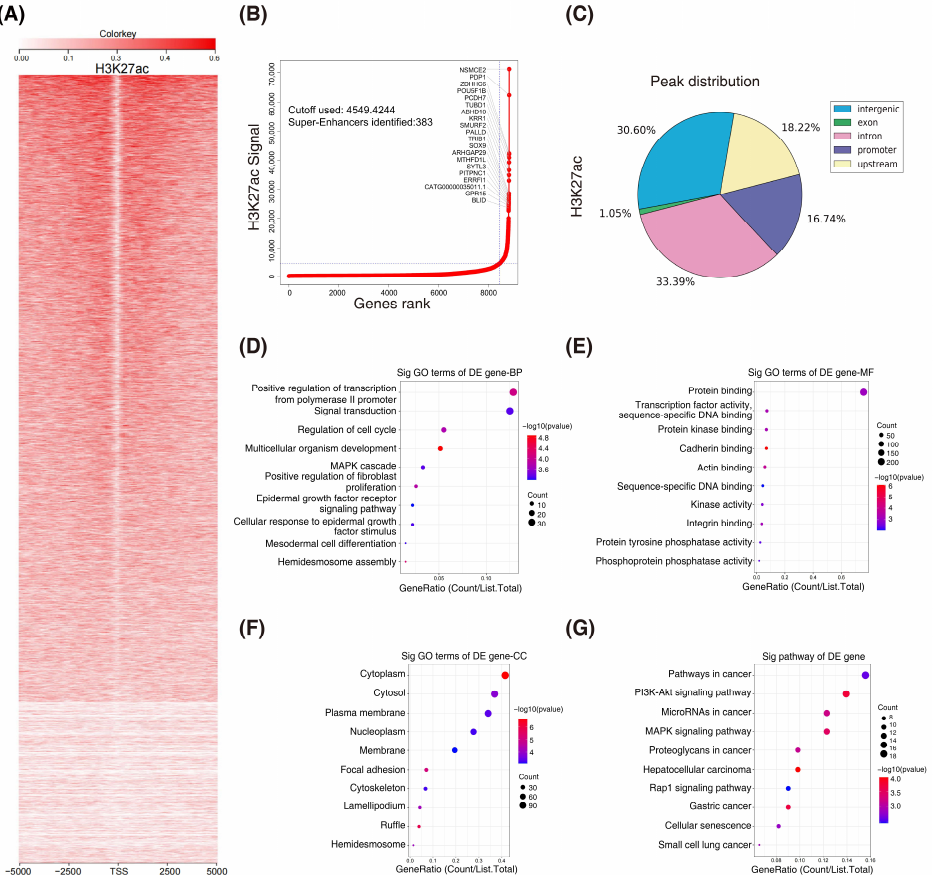
Figure 1. H3K27ac landscape in colorectal cancer. ( A ) Heatmaps of ChIP–seq signals for H3K27ac in HCT116 cells. Scale bar indicates the intensities. ( B ) Hockey stick plots on the basis of input– normalized H3K27ac signals in HCT116 cells. ( C ) Genome–wide distribution of H3K27ac ChIP–seq peaks in HCT116 cells. ( D – G ) Gene ontology (GO) and KEGG analyses of the super–enhancer associated genes. (BP, biological process; MF, molecular function; CC, cellular component; KEGG, Kyoto encyclopedia of genes and genomes).